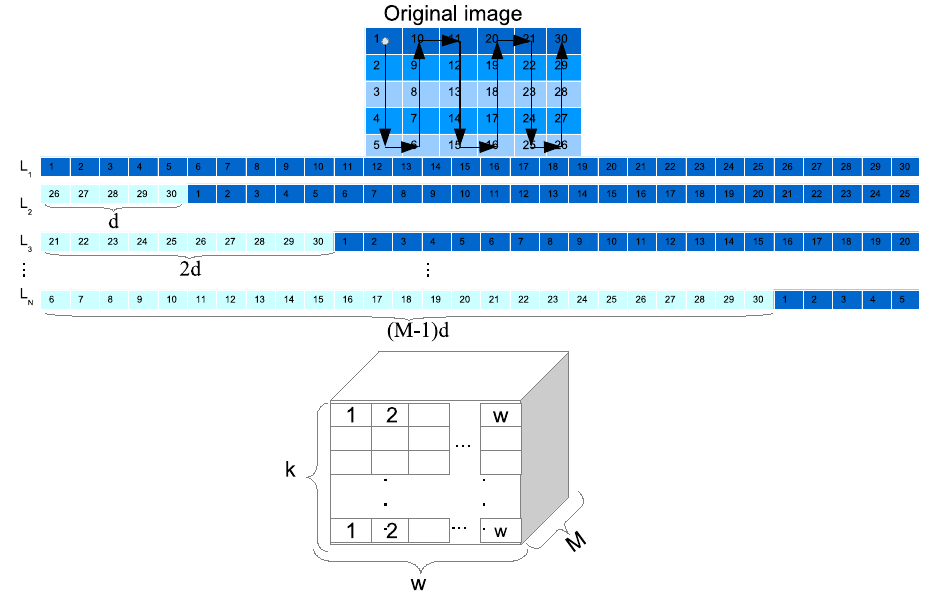
Figure 10. Representation of a query image construction into N